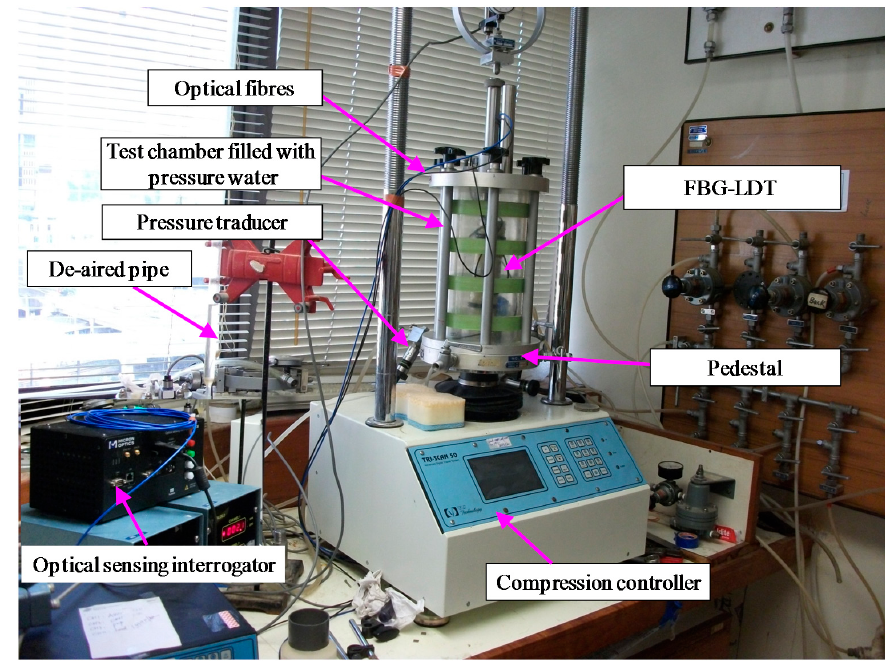
Figure 8. Schematic view of SDT test system in the modified testing apparatus.